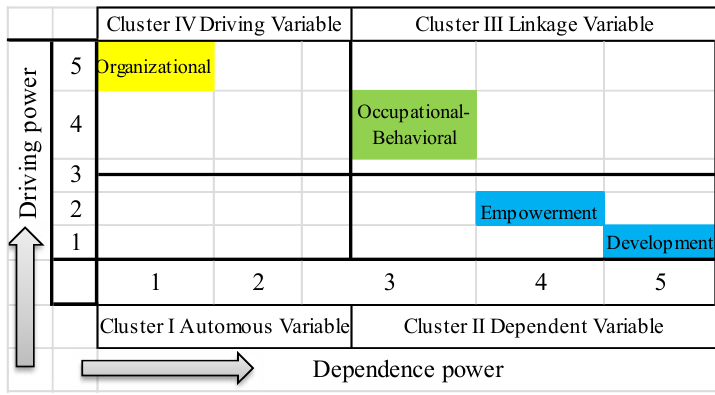
Fig. 4. The analysis of directing– dependence power of HRD components for SOE